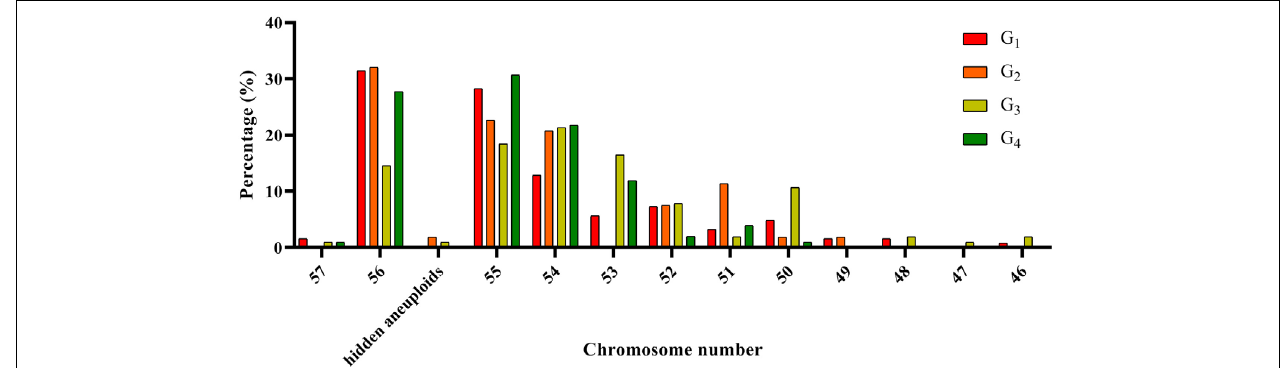
FIGURE 6 | Distribution of the number of chromosomes in the four experimental groups.